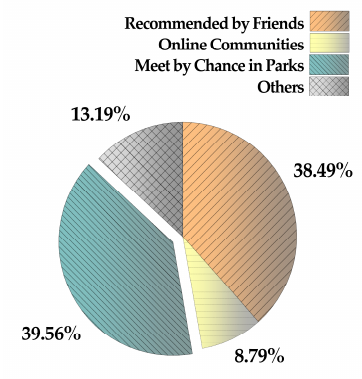
Figure 8. Channels used for joining elderly group activities.